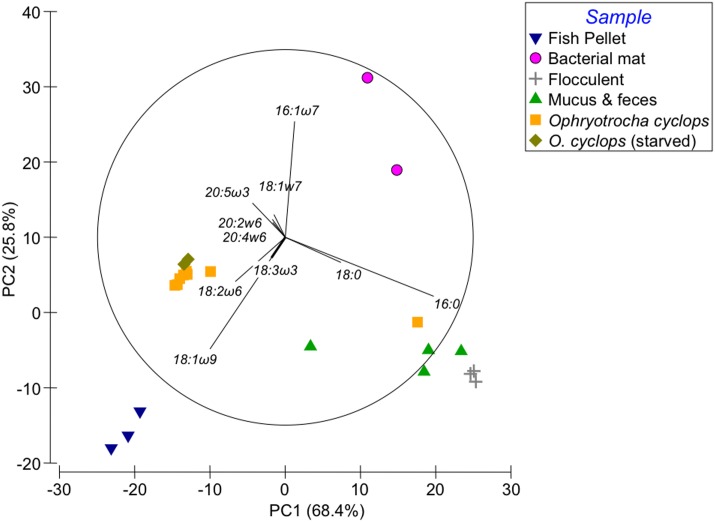
Principal Components Analysis.PCA was run on untransformed FA data (for correlations up to 0.1) and individuals have been superimposed on the figure.